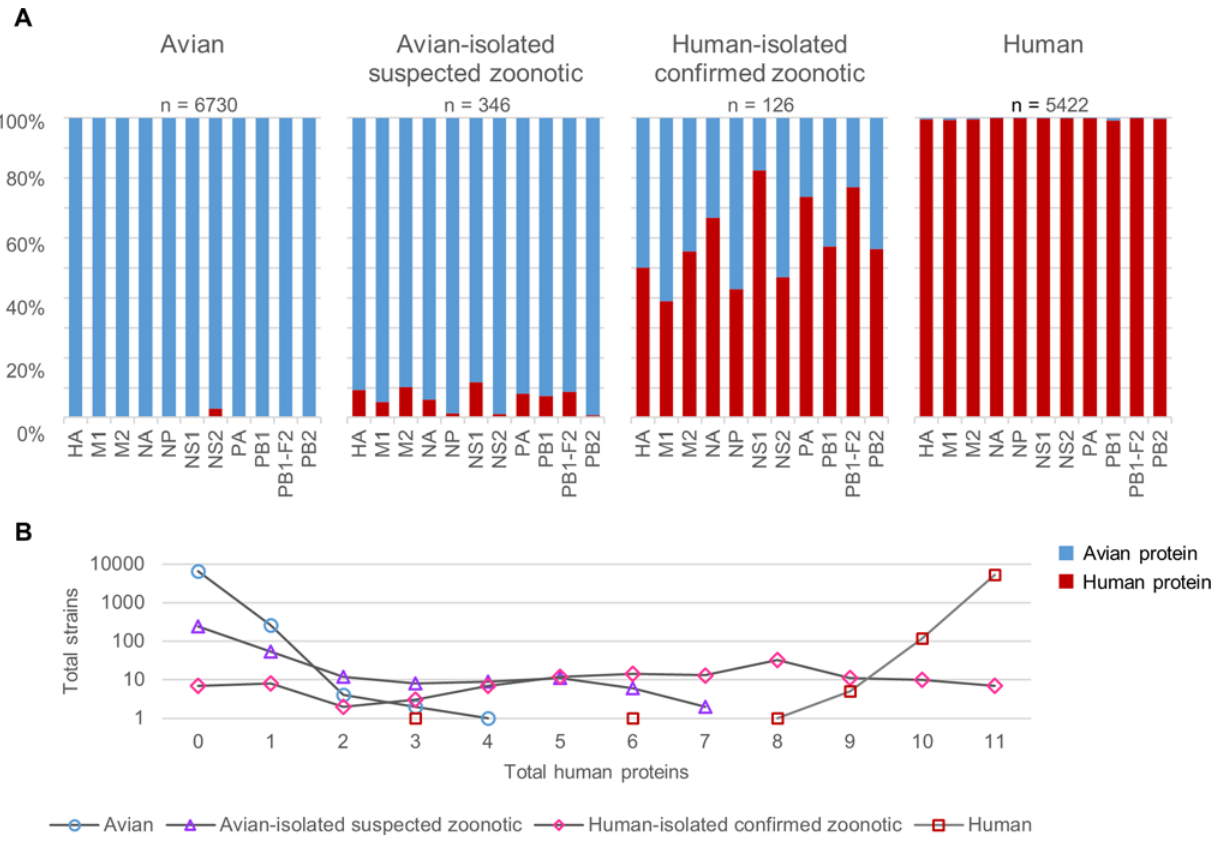
Fig 2. Percentage predictions and total number of human proteins for avian, human and zoonotic strains. (A) 100% stacked bars representing total avian and human predictions for each protein in each group. (B) Total number of human proteins in the host tropism protein signatures of each group. A logarithmic scale of base 10 was applied to total